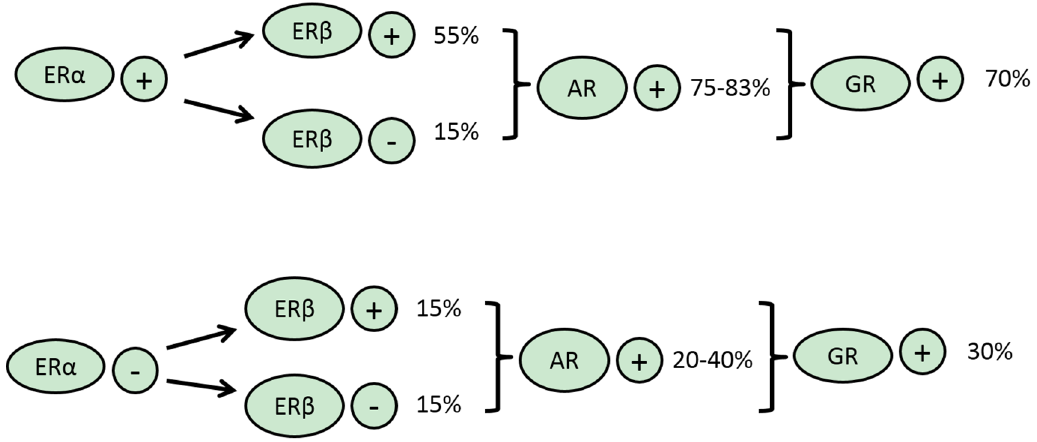
Figure 2. Expressions of other SNRs in ER α -positive and ER α -negative breast cancers.